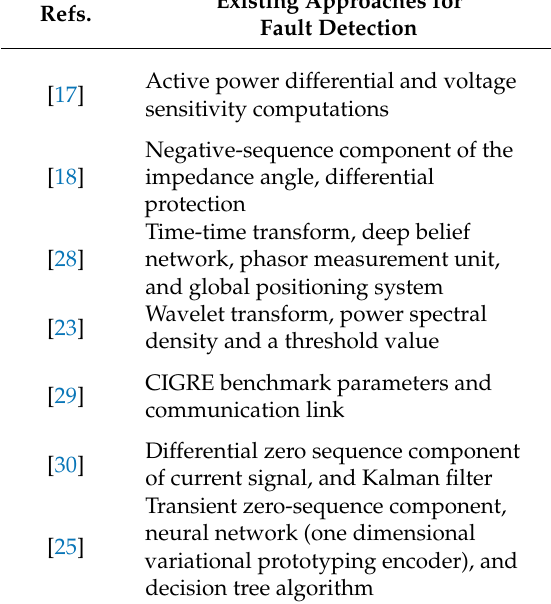
Table 1. Comparison between various existing fault detection approaches.